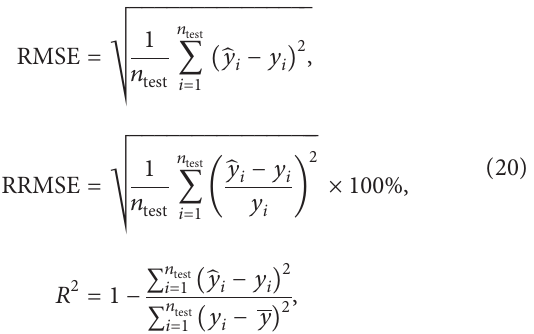
Figure 3. The rubber mixing process lasts for 2 min,